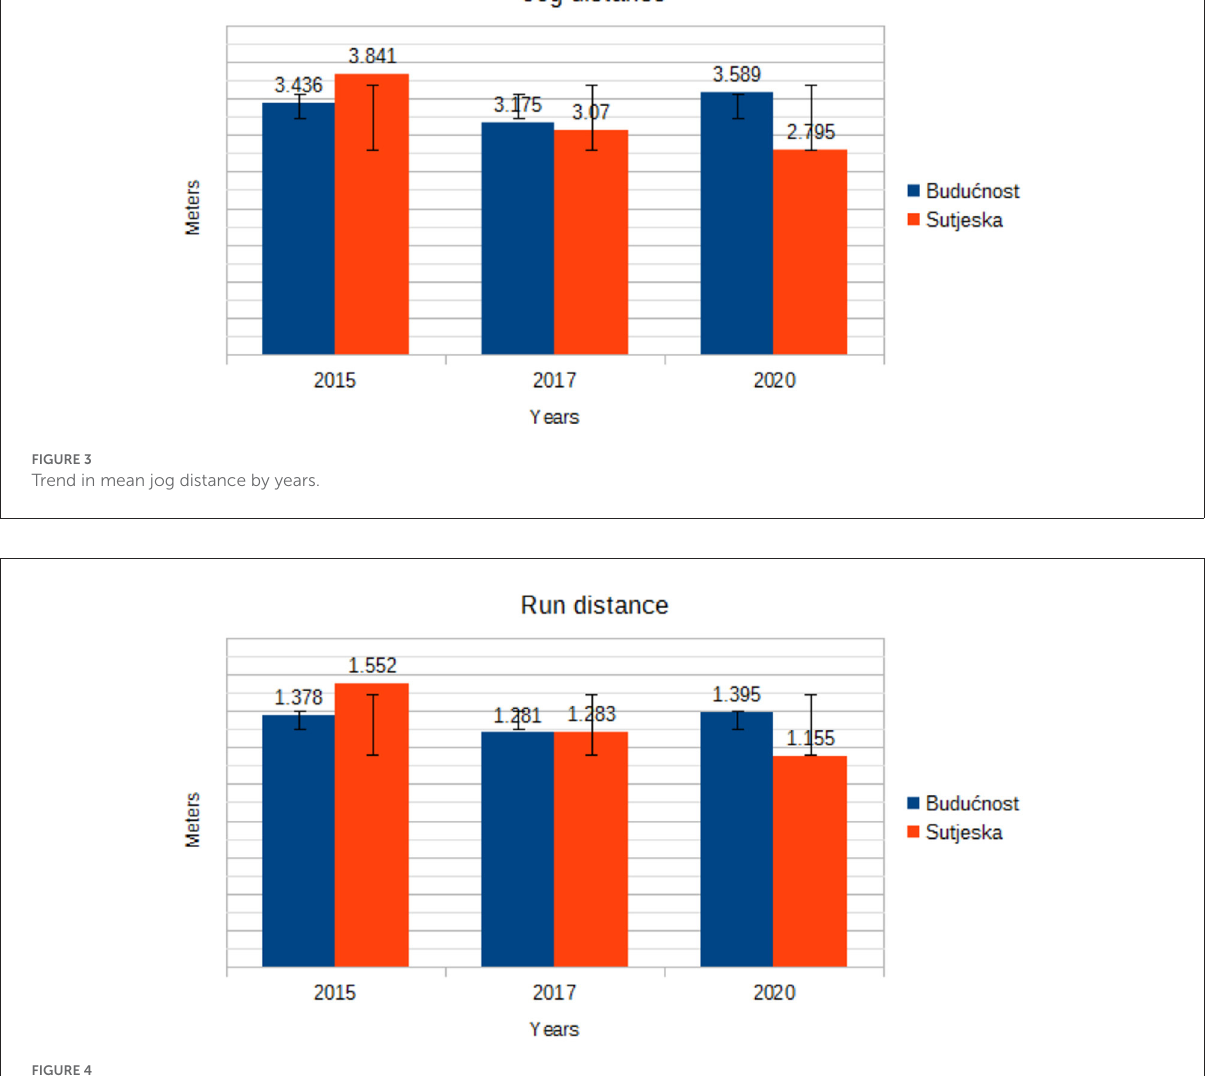
FIGURE4 Trend in mean run distance by